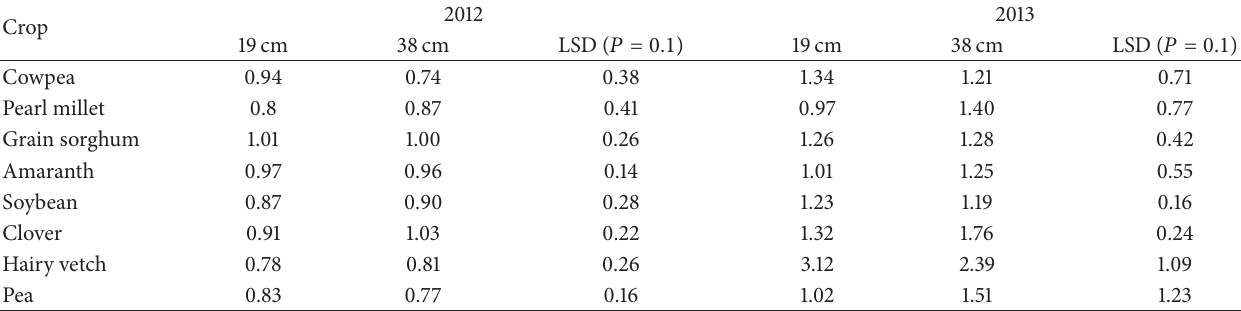
Table 6: Land equivalent ratios (LER) for intercropping of wheat and all alternative crops for 19 and 38 cm row spacing. Crop Cowpea Pearl millet Grain sorghum Soybean